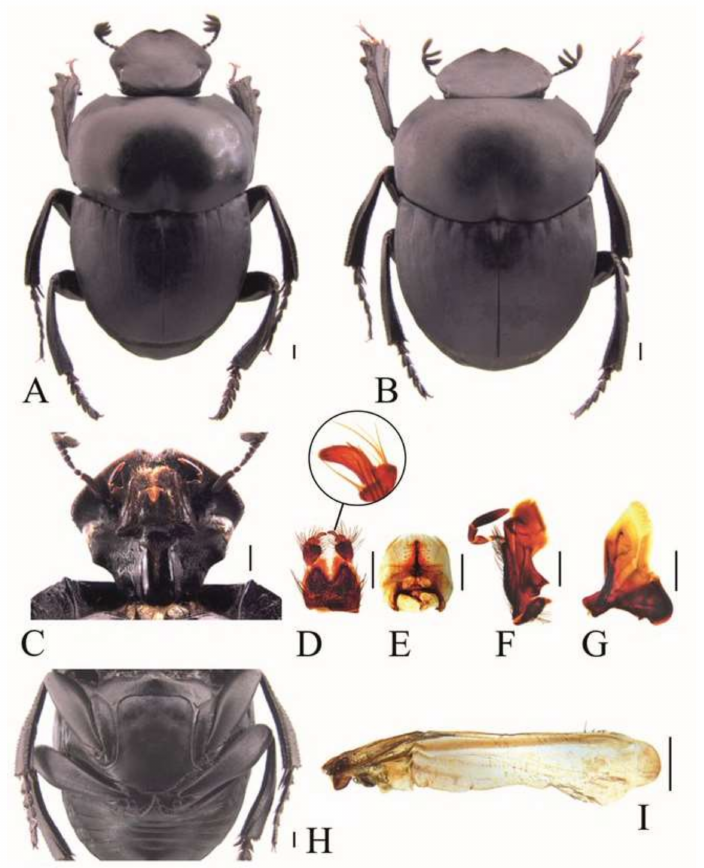
Figure 2. Bajacanthon subgen. nov. ( A ), dorsal habitus of Canthon ( Bajacanthon ) obliquus major male; ( B ), dorsal habitus of a minor male; ( C ), gula; ( D ), labium; ( E ), epipharynx; ( F ), right maxilla; ( G ), right mandible; ( H ), ventral view showing mesoventrites, metaventrites and mesocoxae; ( I ), reduced metathoracic wing. Scale = 0.5